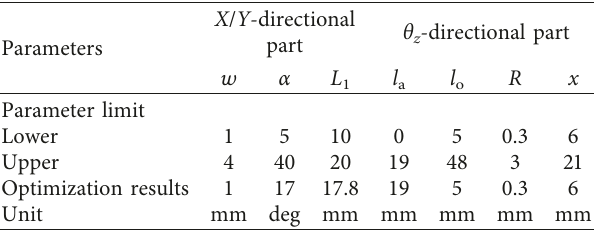
Figure 13: Dependence of the angle travel θ Table 2: Optimization parameters and results.